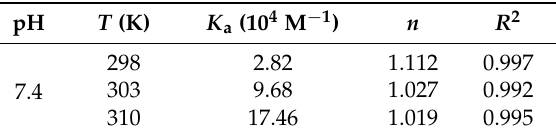
Table 3. Binding constant K a and the number of binding sites n at different temperatures were deduced from Figure 5 as described [16]. λ ex = 295 nm, λ em = 300–450